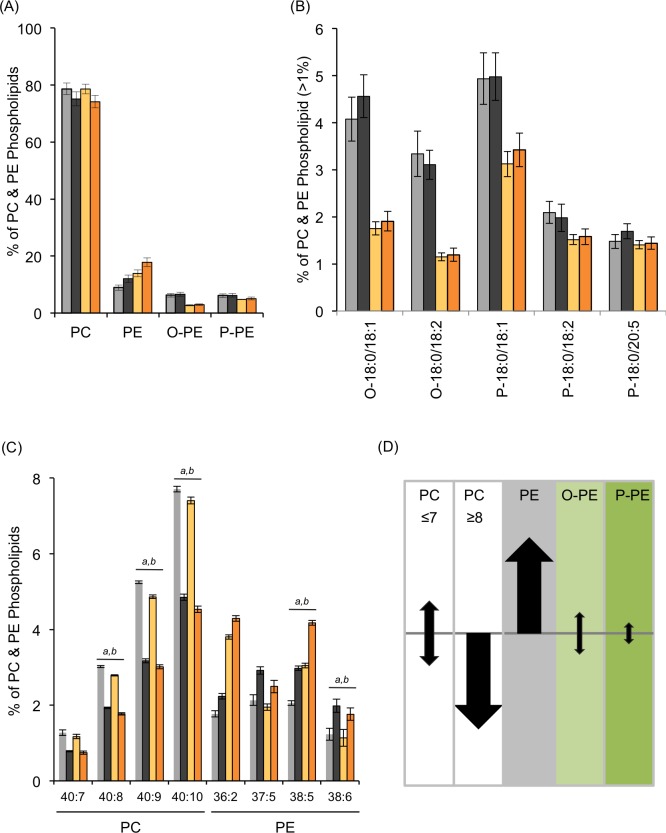
Elevated Oxidative Stress does not Impact Ether Lipid Abundance.The abundance (A) and distribution (B) of O-PE and P-PE within the major phospholipids in L4440-fed animals before (grey) and after (black) 100mM PQ treatment is shown. The same comparisons were done in adult-only fard-1 treated animals before (yellow) and after (orange) stress treatment. (C) All PC and PE species with significant changes are represented, and the full list is available in the S3 Dataset. Biochemical analysis was done on at least 12 biological replicates with SEM shown. For simplicity, only changes meeting a statistical significance of p<0.001 are denoted here by a for L4440 RNAi and b for fard-1 RNAi treatment, and the complete statistical analysis is found in the S3 Dataset. (D) Here, we summarize the changes in the membrane phospholipids after paraquat treatment. The model presented here was generated by considering the major phospholipid species (≥ 2%), thus removing species that may have exhibited significant changes after PQ treatment but compose a very small fraction of the total phospholipids. The PC pool was divided into a group containing ≤7 double bonds and one with ≥8 double bonds as these populations behaved in distinct manners.